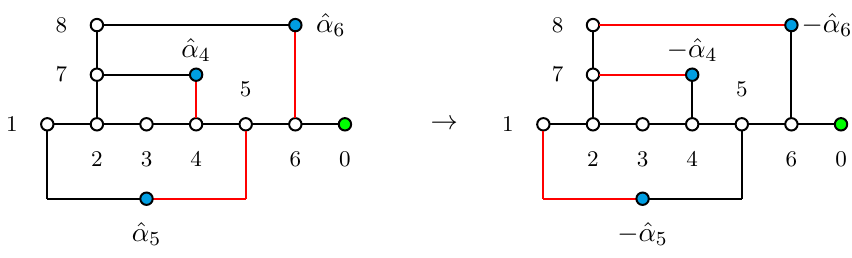
Figure 9. Links between the a(cid:14)ne roots ^ (cid:11) 4 , ^ (cid:11) 5 , ^ (cid:11) 6 and the roots of the a(cid:14)ne E 8 diagram. Black (red) links correspond to inner products with value -1 (+1). The diagram to the right is obtained by (cid:13)ipping the signs of the ^ (cid:11) i .